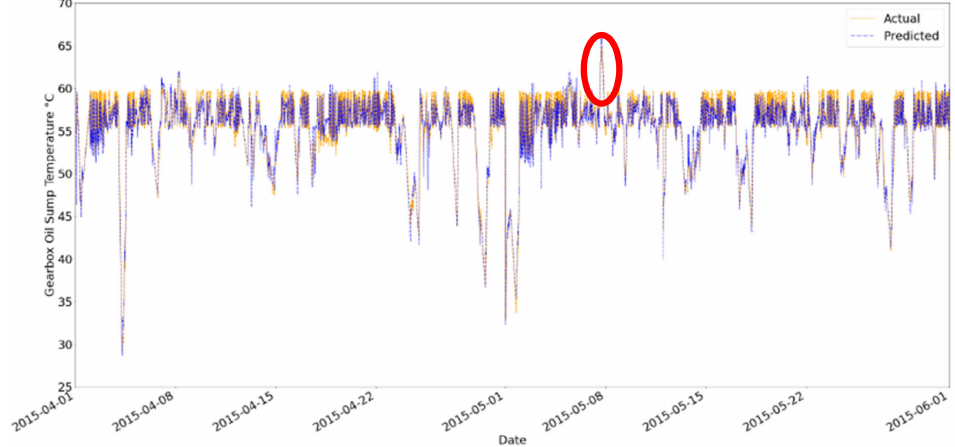
Figure 20. Predicted and Actual Gearbox Oil Sump Temperatures in R80790 WT vs. Date [April 2015 to June 2015].